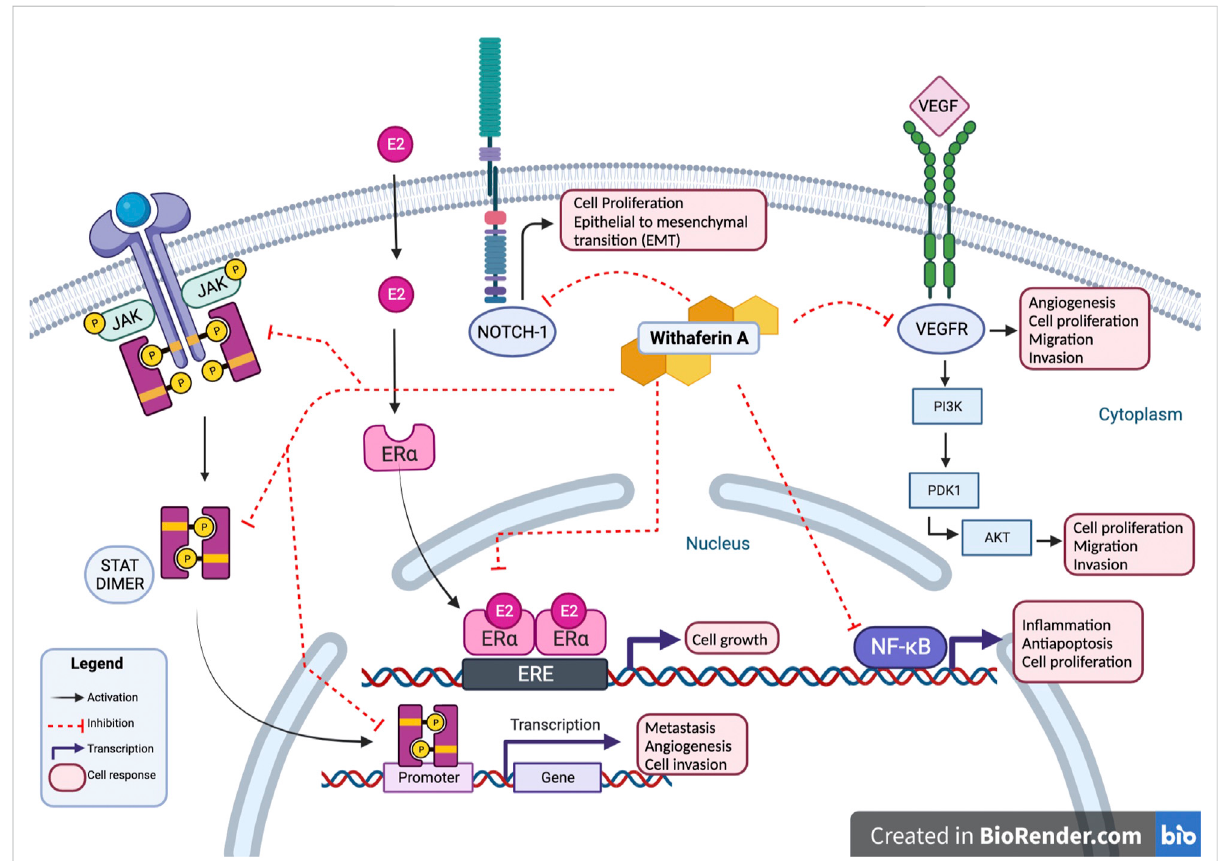
FIGURE 3 Withaferin A interactions. Withaferin A interactions with multiple intracellular proteins leads to modulation of cancerous activity of cell. Withaferin A has antagonistic activity with NOTCH-1, VEGFR, and JAK/STAT in cytoplasm. In cell ’ s nucleus, Withaferin A inhibits activity of transcription factors NF- κ B, ER- α , and STAT3; preventing transcription of their downstream products. These interactions inhibit cancerous cell activity marked by cell proliferation, epithelial to mesenchymal transition, angiogenesis, cell proliferation, metastasis, and cell